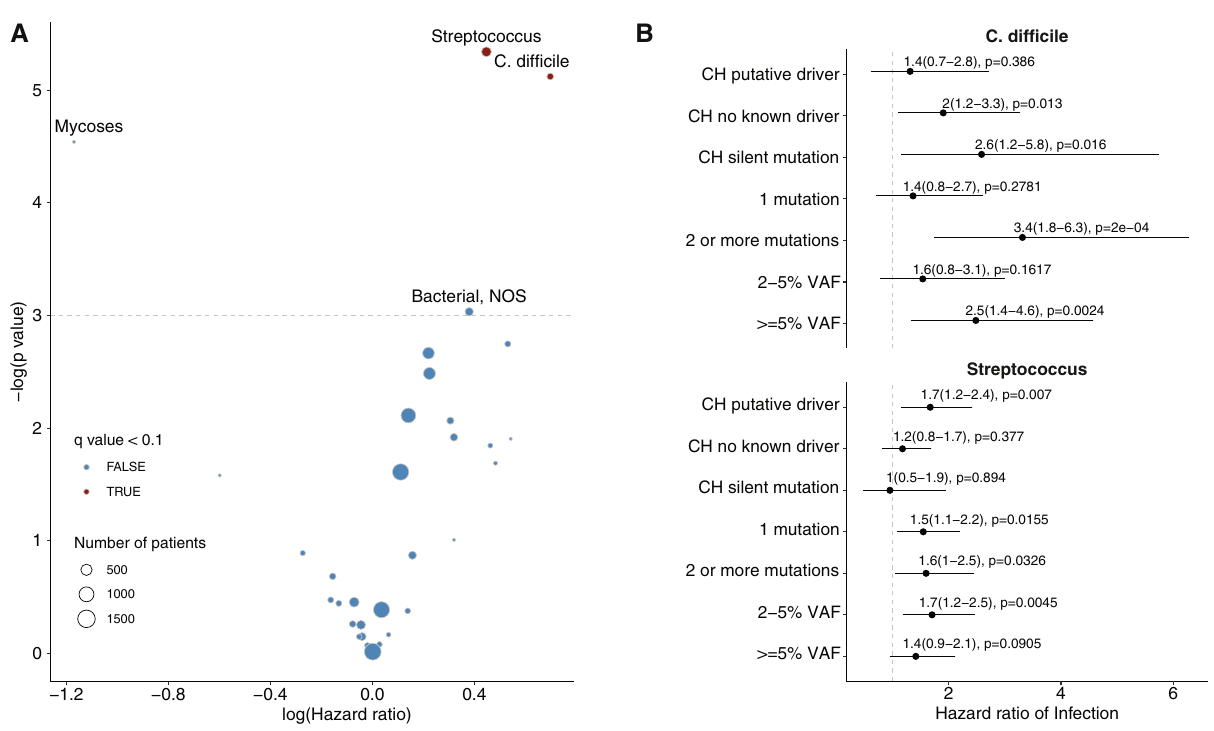
Fig. 2 Association between CH and risk of infection in 14,211 solid tumor patients. A Volcano plot of the log(Hazard ratio) of infection with CH using multivariable cox proportional hazards regression. Any CH includes both driver (CH-PD) and non-driver mutations (CH-non-PD). B Association between CH subtype de fi ned by CH putative driver status and risk of Clostridium Dif fi cle ( N = 189) and Streptococcus/Enterococcus ( N = 501) infection using cox proportional hazards regression. All models were adjusted for age, gender, race, smoking, cancer primary site, cumulative exposure to cytotoxic cancer therapy before and after blood draw. Shown is the hazard ratio for infection, associated 95% con fi dence interval, and p value (not adjusted or multiple